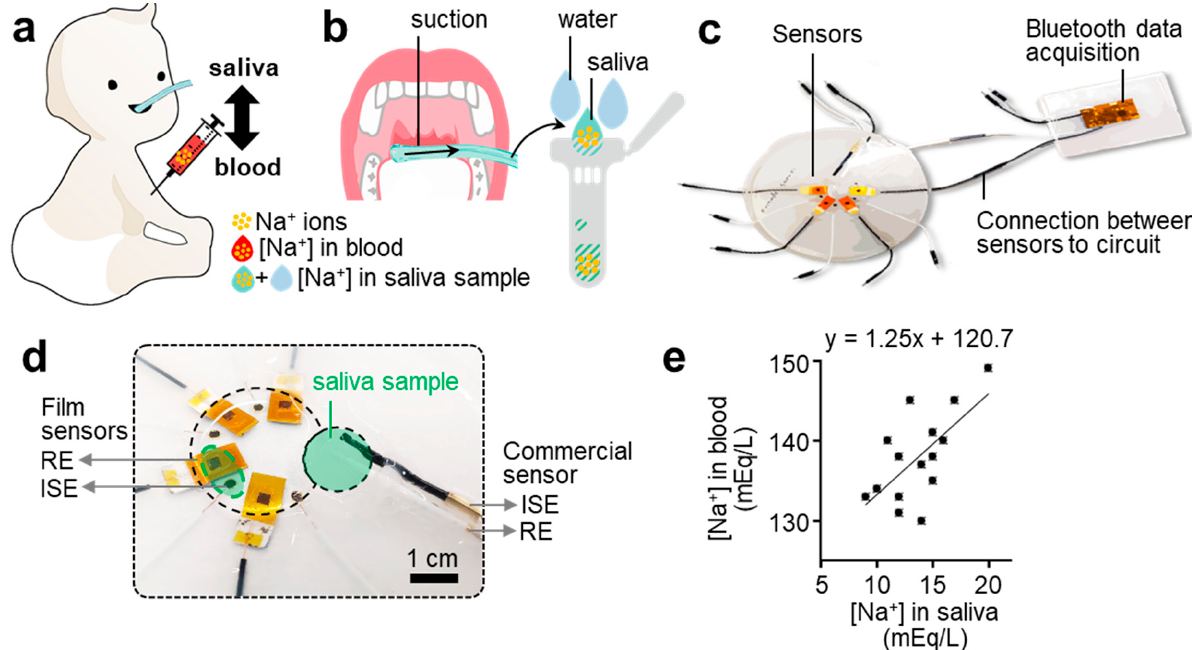
Figure 1. Flexible electrochemical sensor system for non-invasive detection of salivary sodium ions. ( a ) Schematic illustration of an infant subject to extract both saliva and blood samples to validate the sodium sensor performance. Direct, invasive blood sampling is less favored due to discomfort, bruising, and infection. ( b ) Illustration of a non-invasive saliva sample collection process. ( c ) Photo of an integrated system, including thin-film electrochemical sensors and a low-power wireless circuit for data acquisition. ( d ) Zoomed-in view of a salivary sample loading area with both film sensors and a commercial sensor, composed of a pair of an ion-selective electrode (ISE) and reference electrode (RE), for the performance validation. The required sample volume for the thin-film sensor system is less than 400 µL, which is much smaller than the requirement (over 1 mL) of a commercial device. ( e ) Positive correlation results of sodium ion levels between blood samples and saliva samples with the flexible sensor for sodium detection (n = 14).